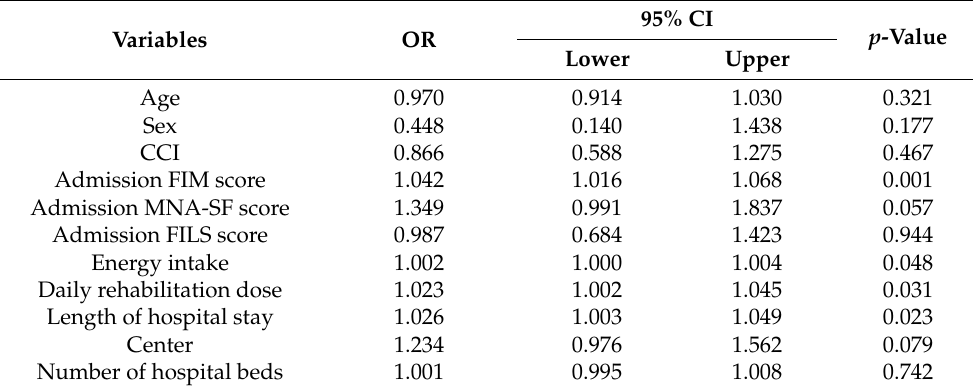
Table 3. Logistic regression analysis of the effect of daily rehabilitation dose on improved nutritional status at hospital